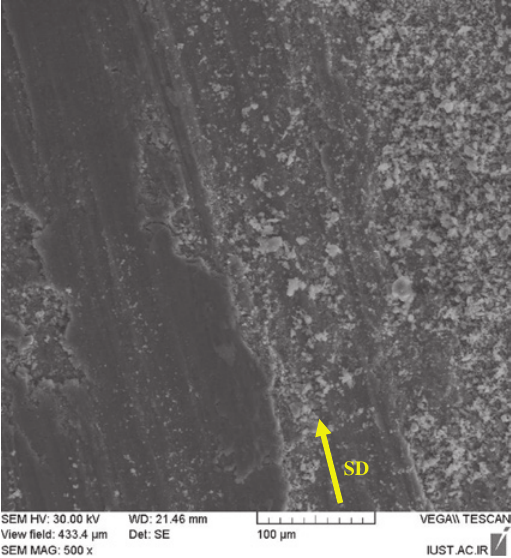
composite at peak p